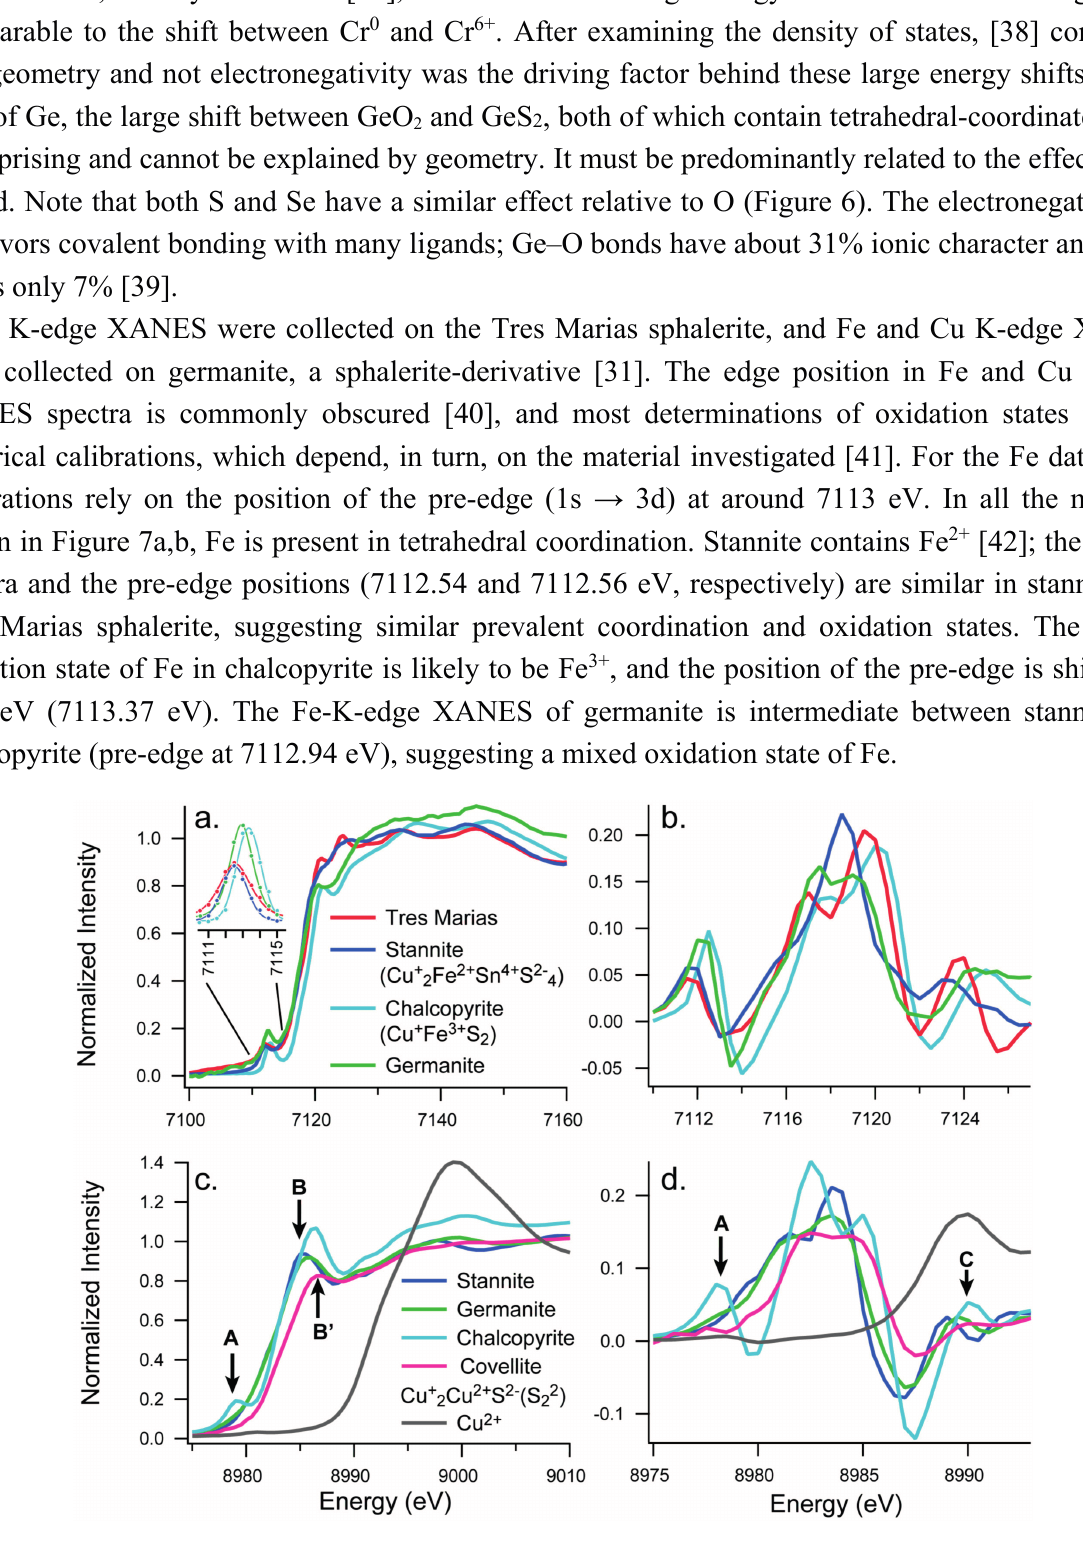
Figure 7. Fe and Cu K-edge XANES data for the Tres Marias sphalerite compared to standards (( a ), ( c ), normalized; ( b ), ( d ), first